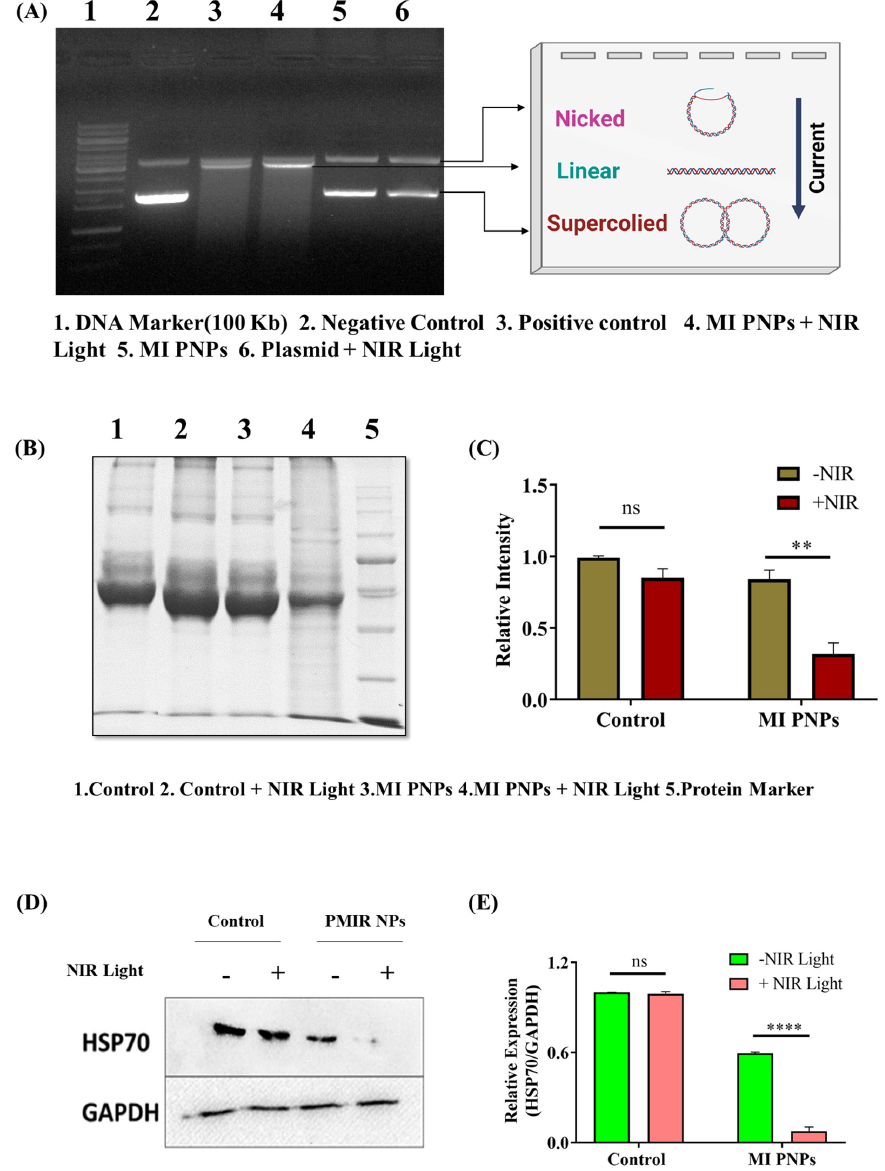
Figure 7. Protein/DNA analysis for the samples that were treated with the MI PNPs in the presence or absence of the NIR light. ( A ) Plasmid denaturation assay indicating the formation of nicked, lin- ear, or supercoiled plasmid content. ( B ) Protein denaturation assay. ( C ) bar graph indicating the relative intensities. ( D ) Western blot analysis for the cell lysates that were treated with the MI PNPs in the presence or absence of the NIR 808 nm light. A two-way ANOVA was used to perform the statistical analysis in ( C , E ) where ** corresponds to p < 0.01 and **** corresponds to p < 0.0001 4. Conclusions In this study, we report the role of a bioactive fraction from M. oleifera in the down- regulation of HSP70 expression for a synergistic photothermal therapy in retinoblastoma cell lines. The hydrophobic bioactive fraction from M. oleifera was successfully incorpo- rated into a polymeric nano-delivery system. It was tuned photo-thermally active by co-